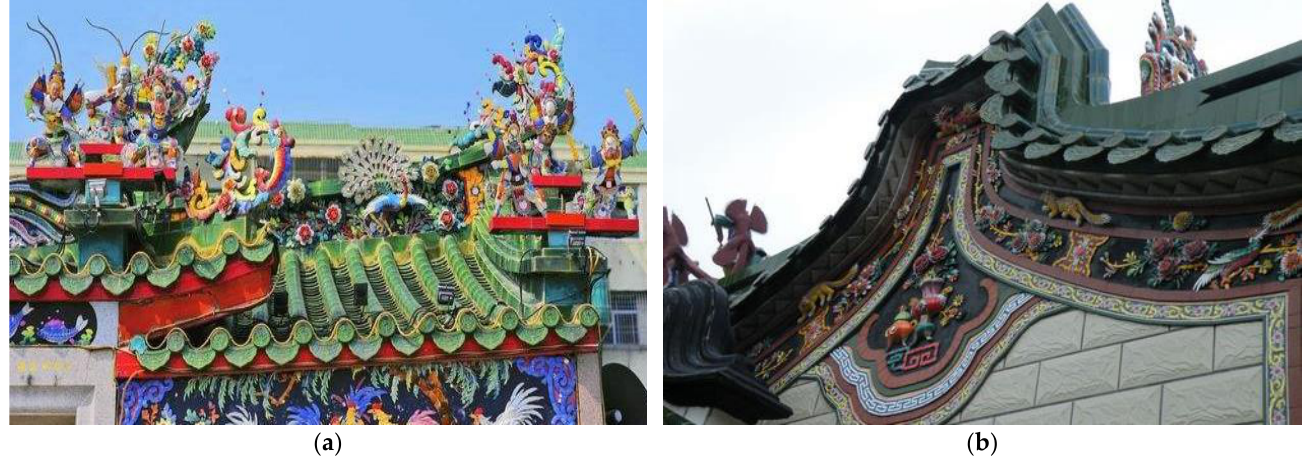
Figure 24. The inlaid porcelain of the Four Points Gold building.